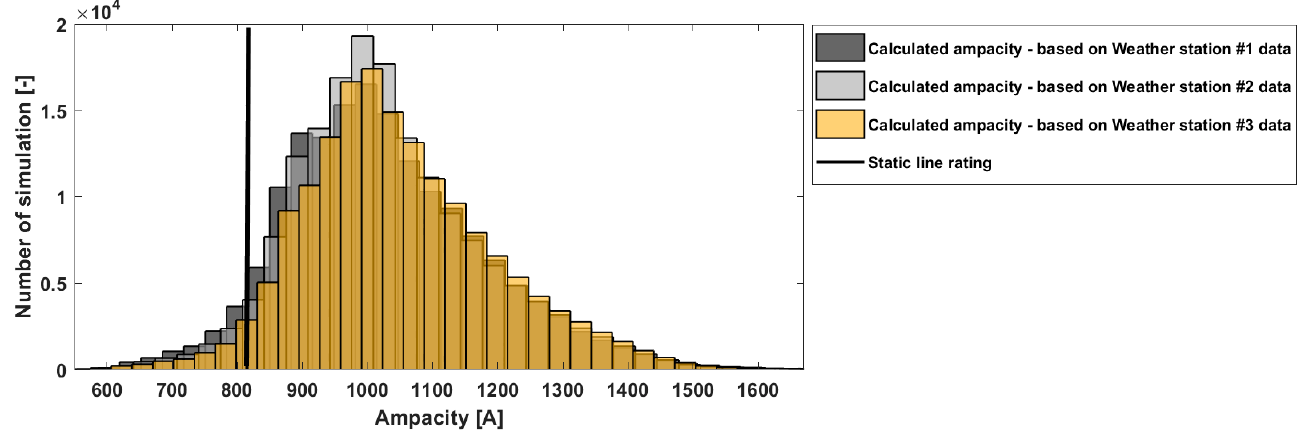
Figure 7. Ampacity results of the extended white-box models from the weather station